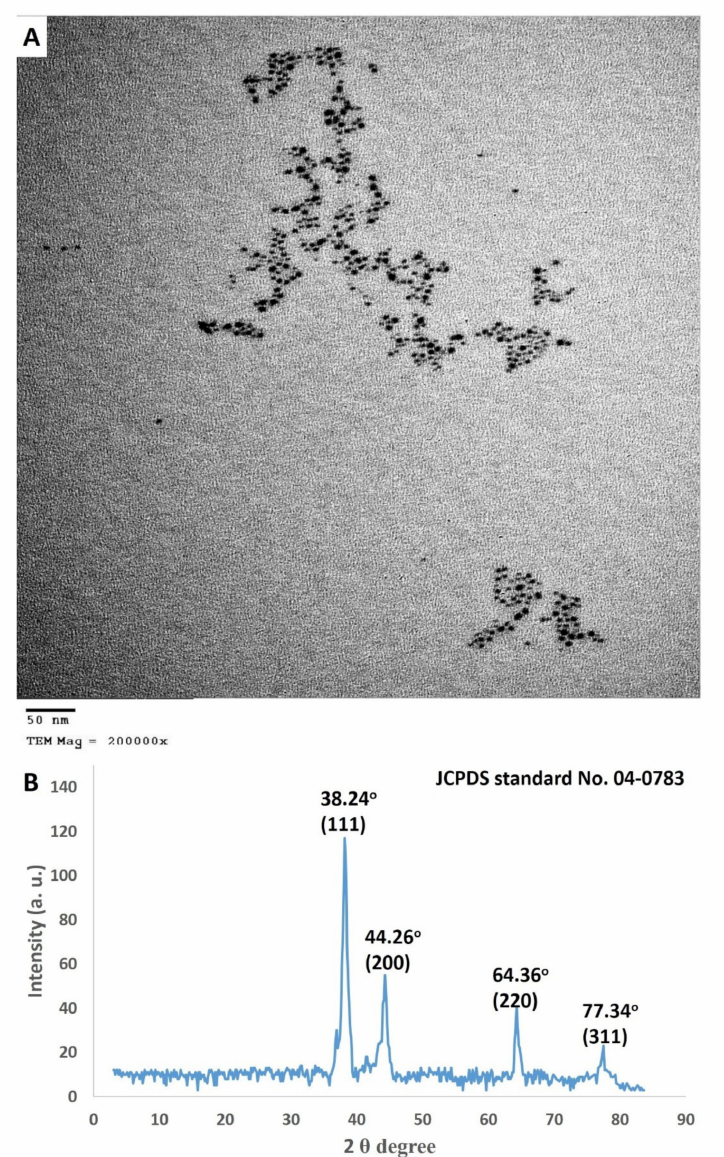
Figure 4. ( A ) Transmission eelectron microscopy (TEM) image showing the spherical shape with sizes ranging from 7 to 15 nm, and ( B ) X-ray di ff raction (XRD) spectra exhibiting the crystalline nature of Ag-NPs synthesized by endophytic S. laurentii R-1. at specific 2 θ values. The bio-silver nanoparticles (12.5 ppm) were e ffi cient against the Gram-positive pathogen Bacillus subtilis ATCC 6633 and the Gram-negative pathogens Pseudomonas aeruginosa ATCC 9022, Escherichia coli ATCC 8739 with zones of inhibition (ZOIs) of 11 ± 0.89, 12.66 ± 0.52, and 10.33 ± 0.51 mm, respectively (Figure 5). Doubling the Ag-NPs concentration (25 ppm) conferred better e ffi ciency, and the ZOIs increased to 14 ± 0.9, 15.5 ± 0.5, and 12 ± 0.9 mm for the pathogens B. subtilis , P. aeruginosa , and E. coli , respectively. Moreover, the Gram-positive pathogen Staphylococcus aureus ATCC 6538 and the Gram-negative pathogen Salmonella typhimurium ATCC 14028 manifested a positive response for silver nanoparticles at 25 ppm, with recorded ZOIs of 10 ± 0.9 and 10 ± 0.47 mm, respectively. The biocolloidal silver (50 ppm) demonstrated a pronounced activity against all pathogens, recording ZOIs of 11.6 ± 0.5, 18.3 ± 0.5, 13.6 ± 1, 18 ± 0.9, and 12.3 ± 1 mm corresponding to S. aureus , B. subtilis , P. aeruginosa , E. coli , and S. typhimurium